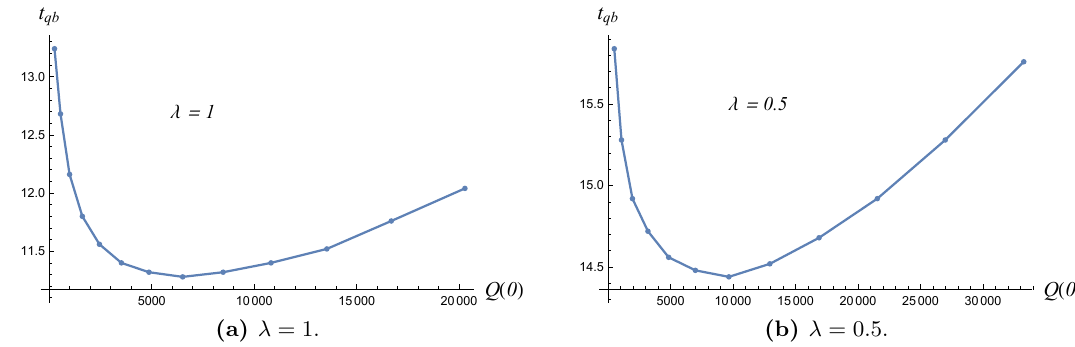
Figure 2 . Quantum break-time as a function of the full